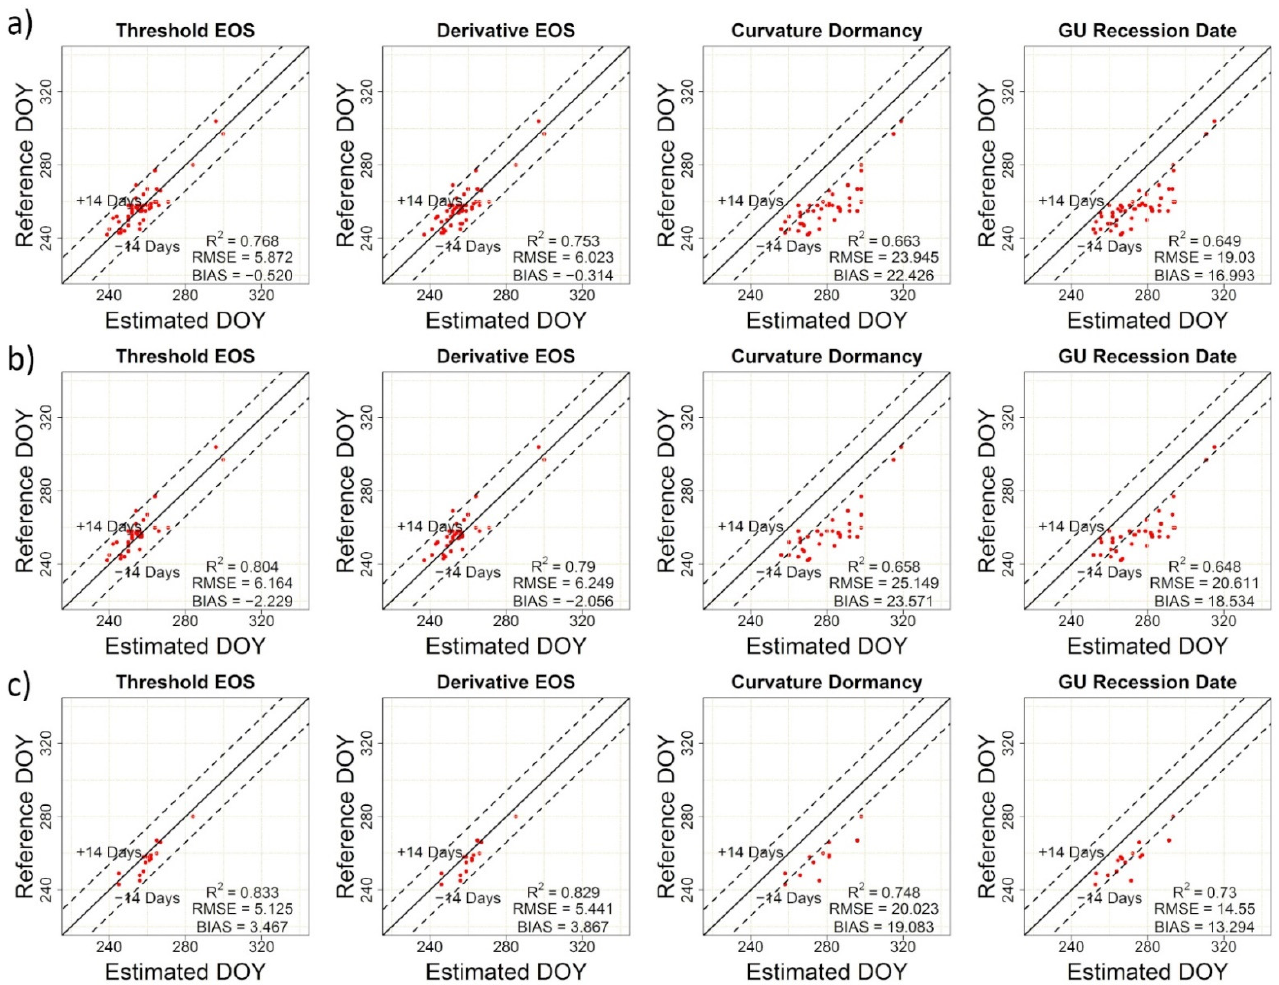
Figure 7. The comparisons between the PhenoCam GCC-based transition date estimates of the greenness falling period and the visually observed maturity for ( a ) both corn and soybean, ( b ) corn, and ( c ) soybean, using the four phenophase analysis methods.